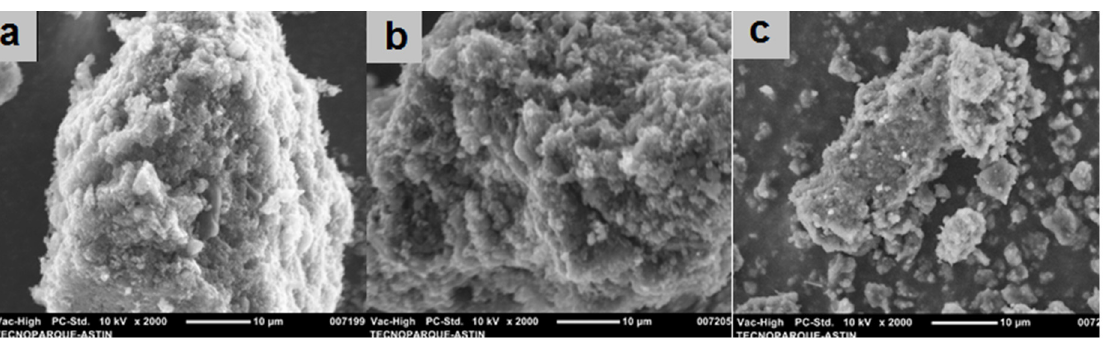
Figure 7. SEM images of the ( a ) p -CNOs, ( b ) ox -CNOs and ( c ) pyr -CNOs.